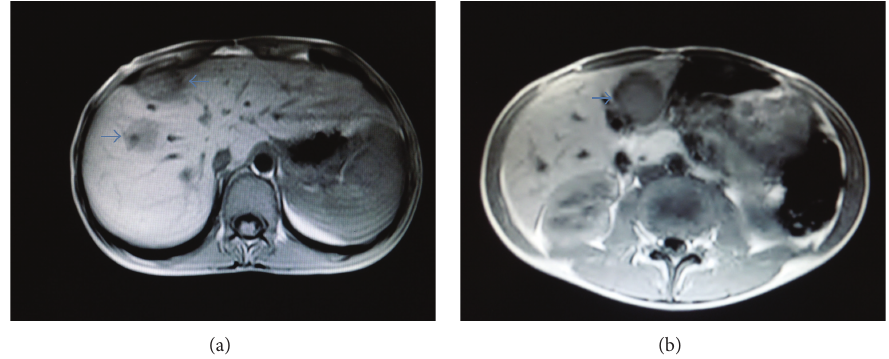
Figure 1: T1 (a) and T2 (b) weighted magnetic resonance imaging shows multiple lesions in the